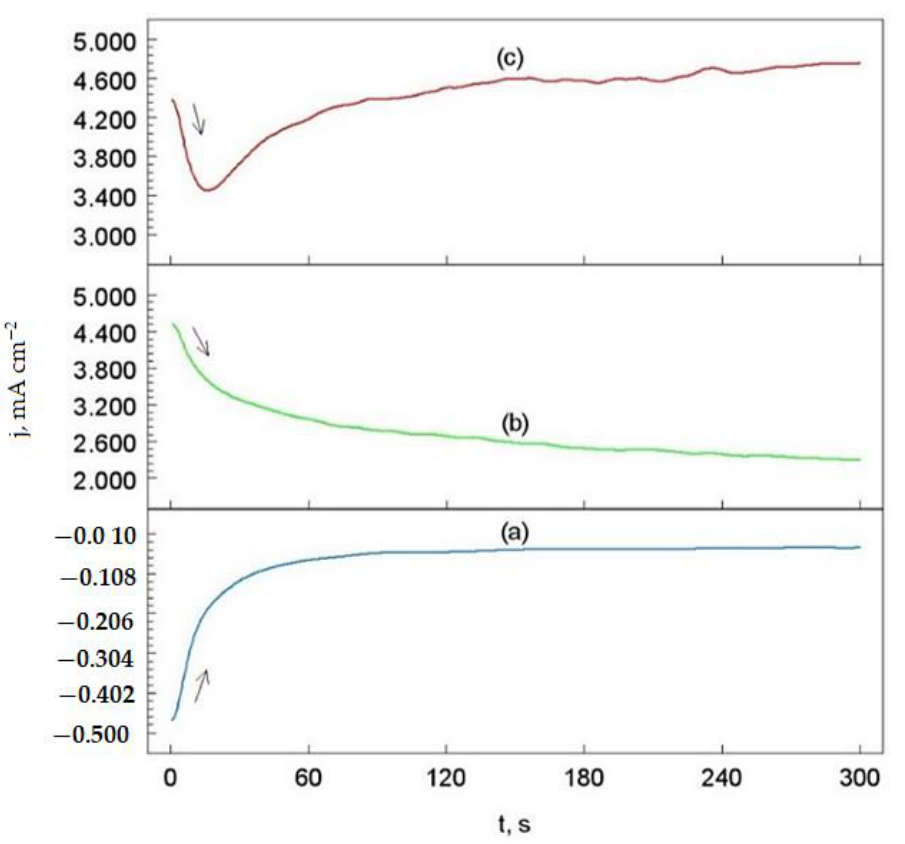
Figure 11. Chronoamperometric curves of the Cr 3 C 2 -25(Ni20Cr) cermet coating on the Al7075 sub- strate after laser remelting for the spot speed of 600 mm/min, obtained for: ( a ) −900 mV, ( b ) −190 mV, and ( c ) −40 mV. Solution contained 1.2 M Cl - , pH 1.5.